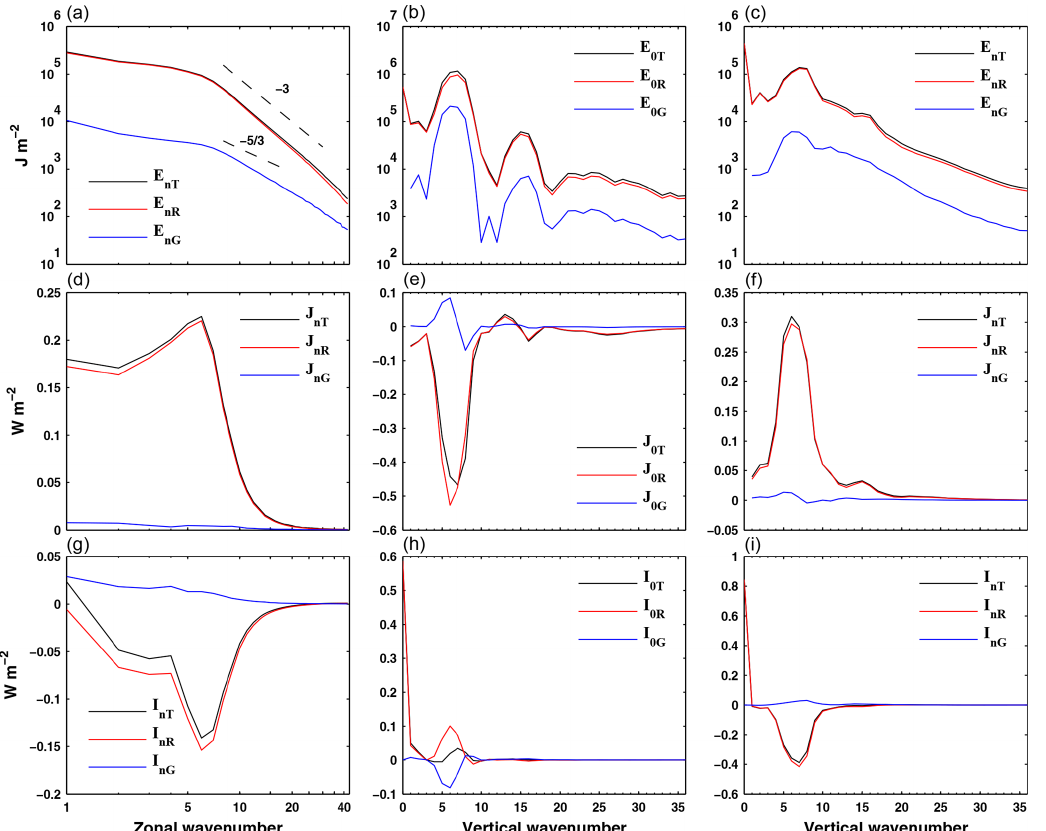
Figure 9. Spectra of total energy E (a, b, c) and of non-linear interactions of available potential J (d, e, f) and kinetic I (g, h, i) energies, in the zonal wavenumber (a, d, g) and the vertical index, separately, for the zonal (b, e, h) (0) and eddy (c, f, i) ( n ) components. In each panel the contributions of the Rossby ( R ) and gravity ( G ) components to the total ( T ) spectra of energy or energy interactions are represented.